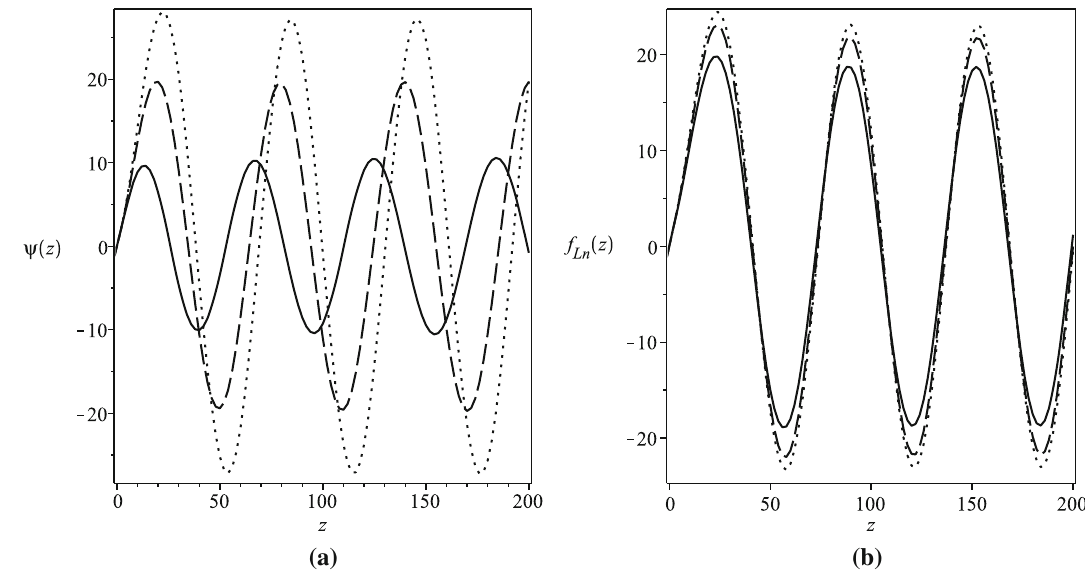
Fig. 12 The profile of a graviton wave function for a = 3 (solid line), a = 5 (dashed line), a = 7 (dotted line) and b right-handed fermion wave function for a = 1 (solid line), a = 2 (dashed line), a = 5 (dotted line), in fermion case we set η =